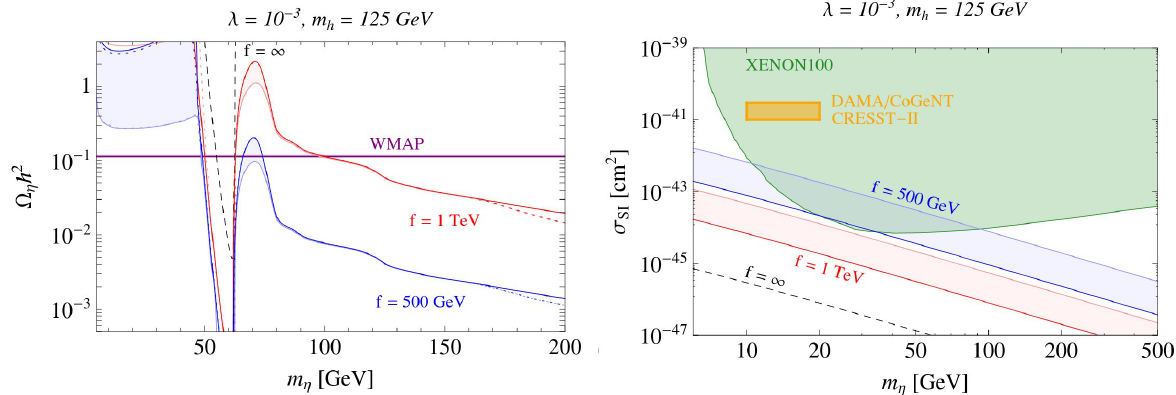
Figure 17: Predictions for the relic density and direct detection for a dark meson η (cid:48)